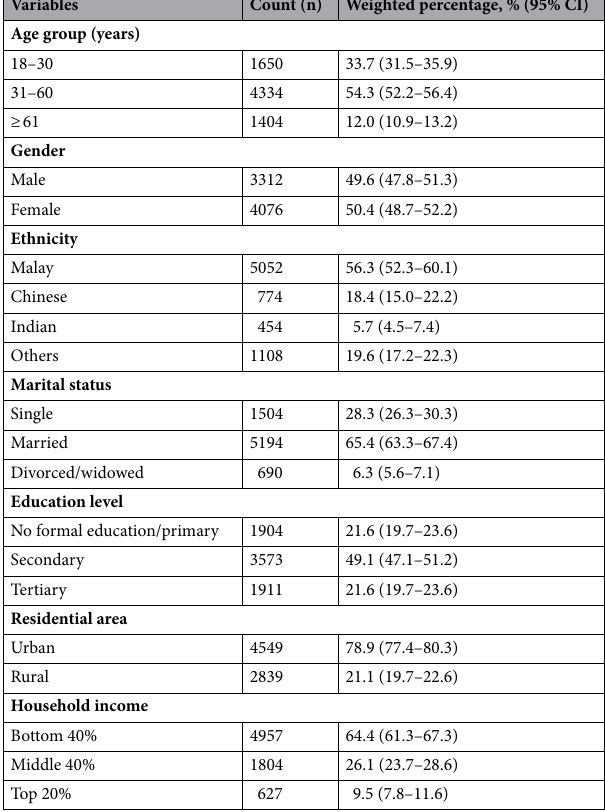
healthy lifestyle scores of 4 and 5 (aOR = 1.74, 95% CI = 1.12, 2.71) compared to older people ≥ 61 years old as reference category. Women were 3.26 times more likely to achieve healthy lifestyles compared to males as